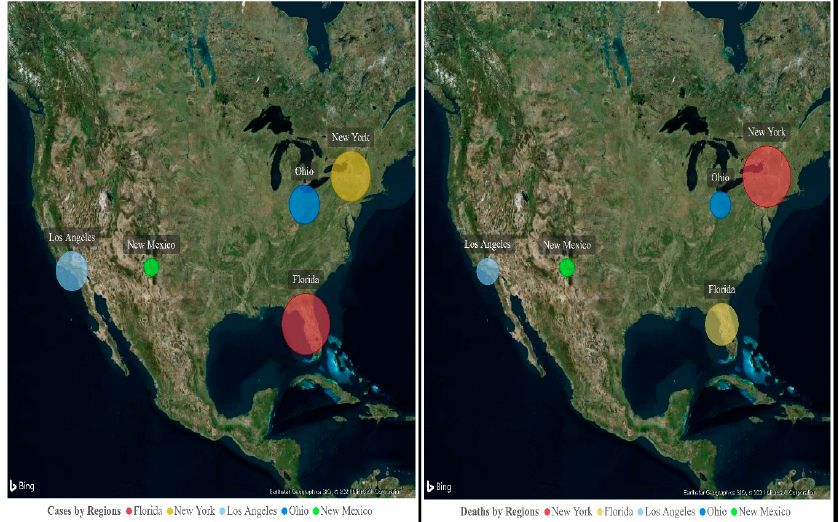
Figure 9. Heat map: spread of SARS-CoV-2 cases and deaths in five different regions of the USA.